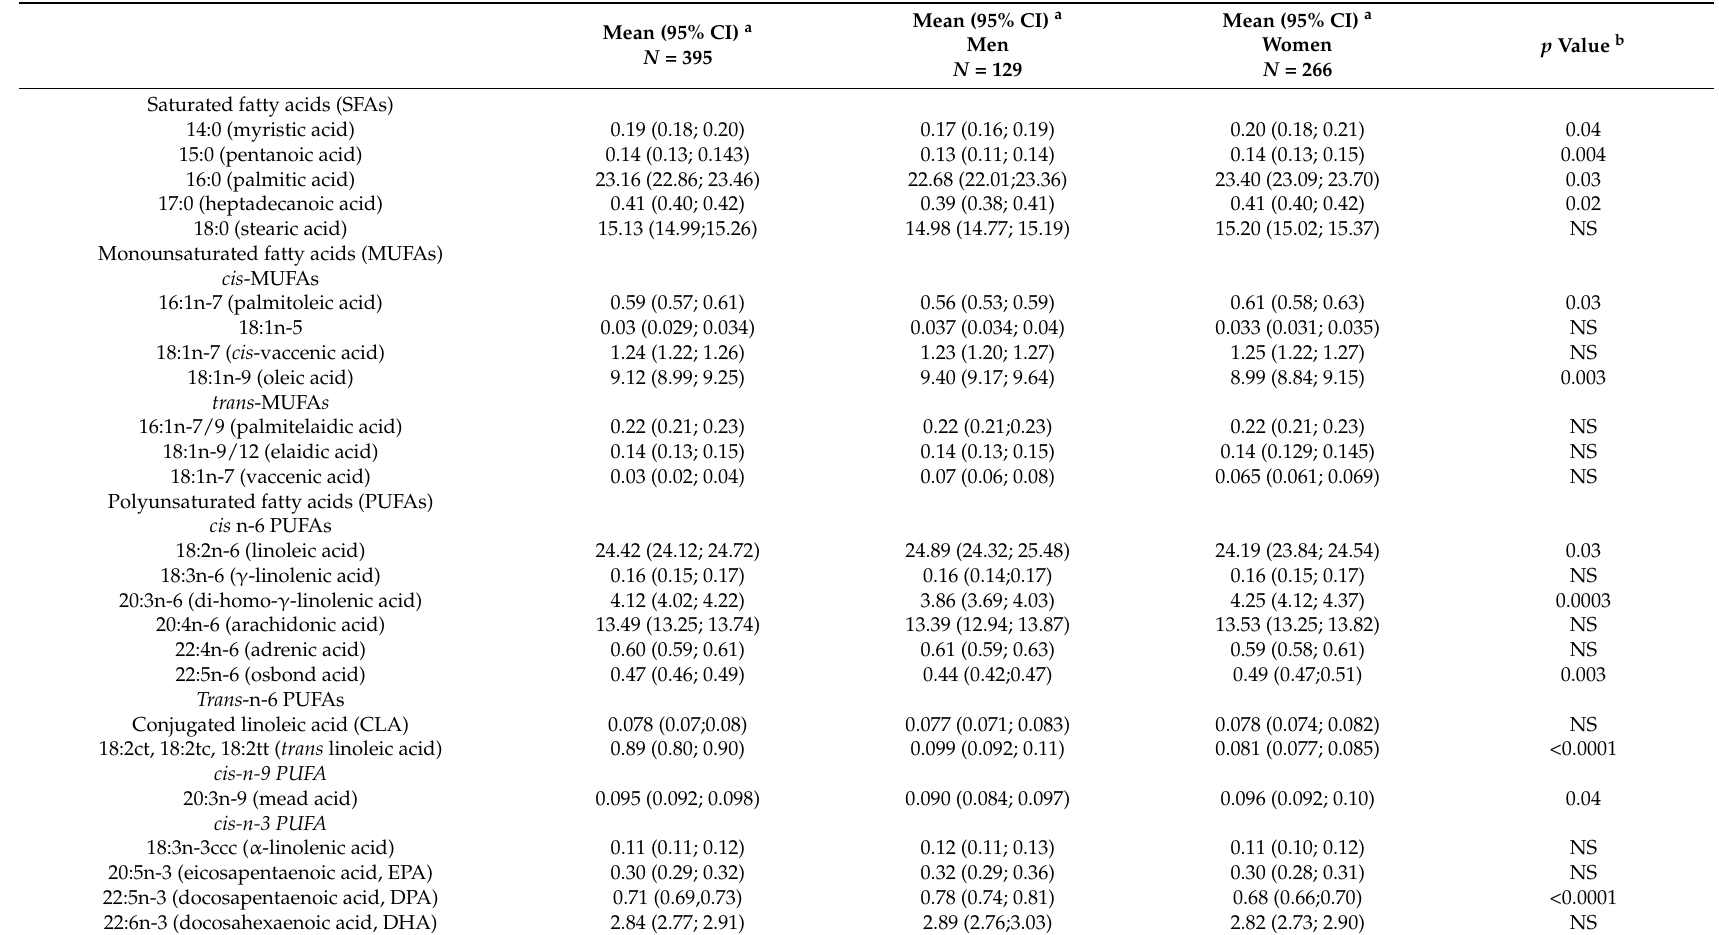
Table 2. Serum Phospholipid fatty acids in the